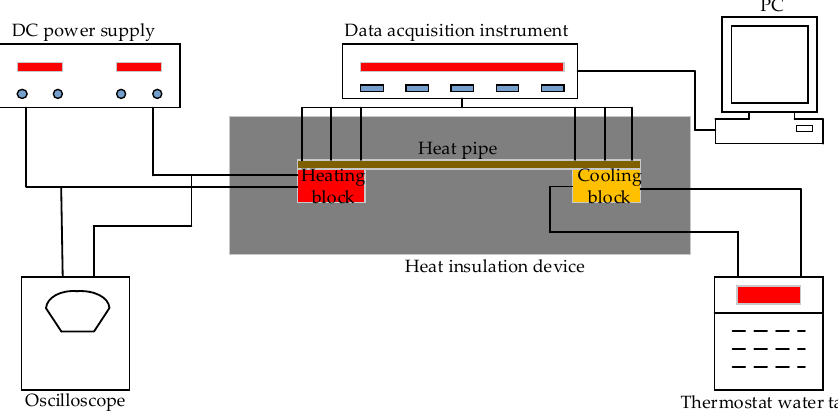
Figure 6. Schematic diagram of the experimental process.